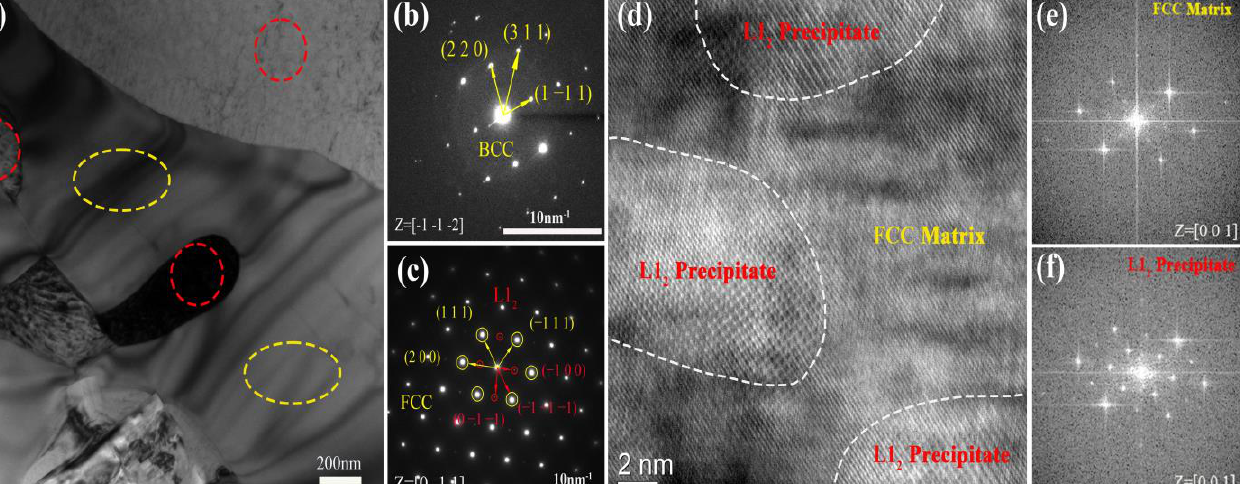
Figure 3. EBSD BC and phase images of the as-cast alloy samples. ( a , c , e ) are BC images for B0.5, Mg0.5, and Zr0.5 HEAs, respectively; ( b , d , f ) are the phase images of B0.5, Mg0.5, and Zr0.5 HEAs, respectively.